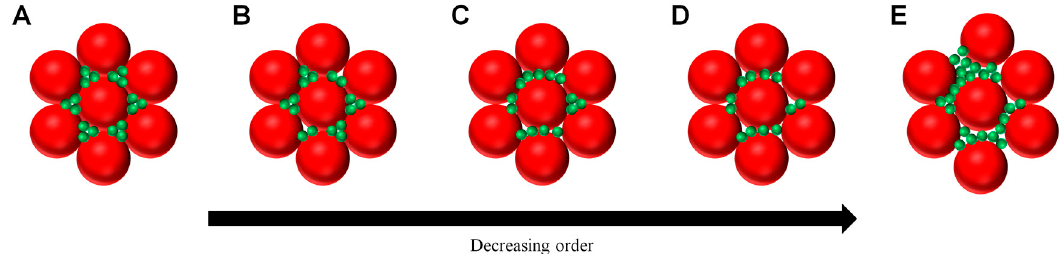
Figure 2. Schematic representation of the uniformity observed in binary colloidal crystals. ( A ) a highly uniform arrangement where the large particles form a hexagonally close-packed structure and small particles deposit evenly into the interstitial spaces; ( B – D ) the small particles deposit less evenly into the interstitial spaces, causing a loss of uniformity to the binary assembly while the large particles maintain a hcp and highly homogenous arrangement; ( E ) Completely disordered arrangement where the hcp arrangement of the large particles is also lost.